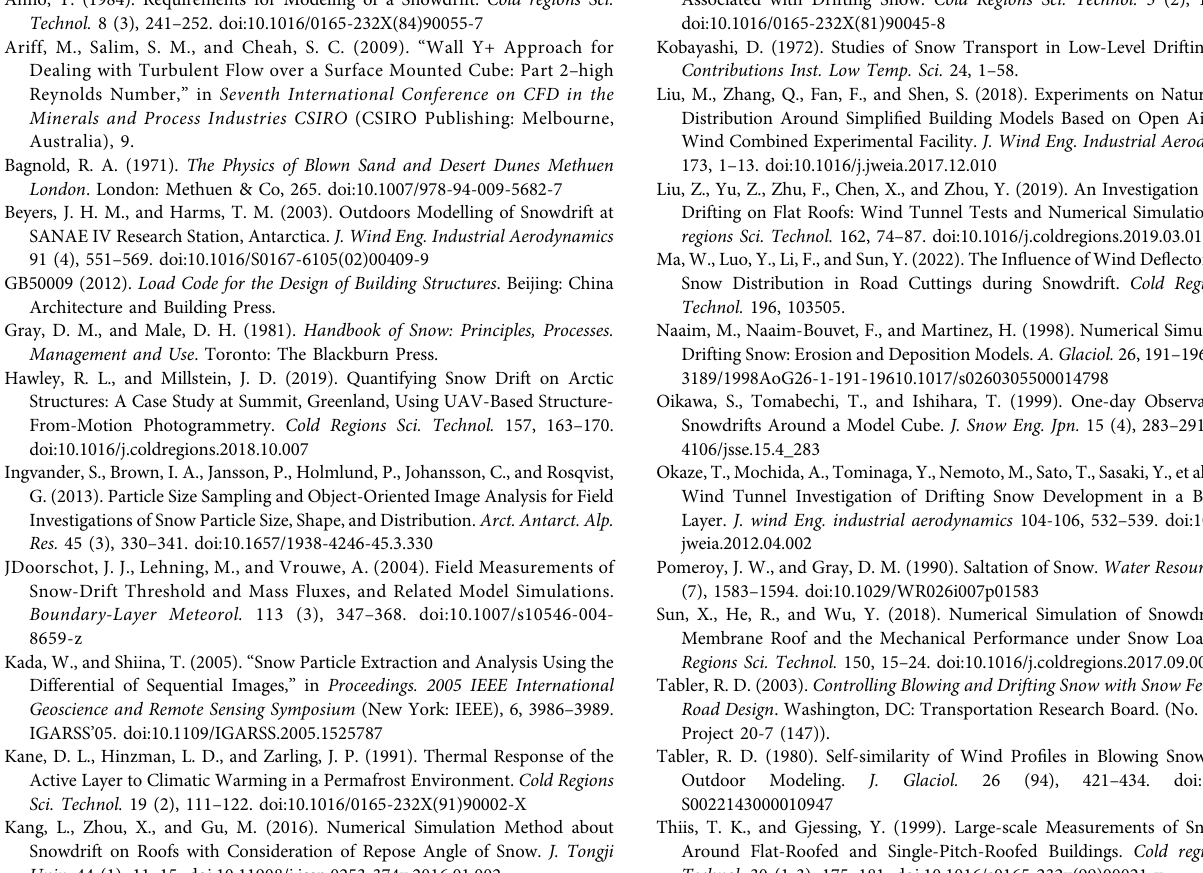
Tabler, R. D. (2003). Controlling Blowing and Drifting Snow with Snow Fences and Road Design . Washington, DC: Transportation Research Board. (No.